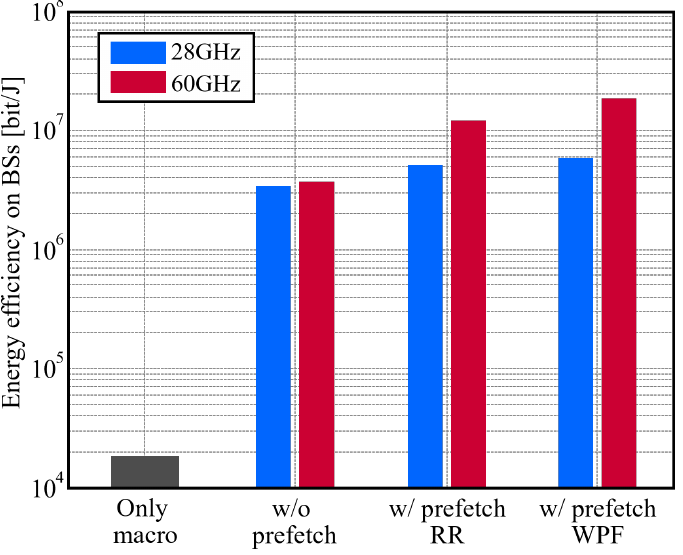
Figure 12. The energy efficiency (1 Gbps backhaul capacity, 200